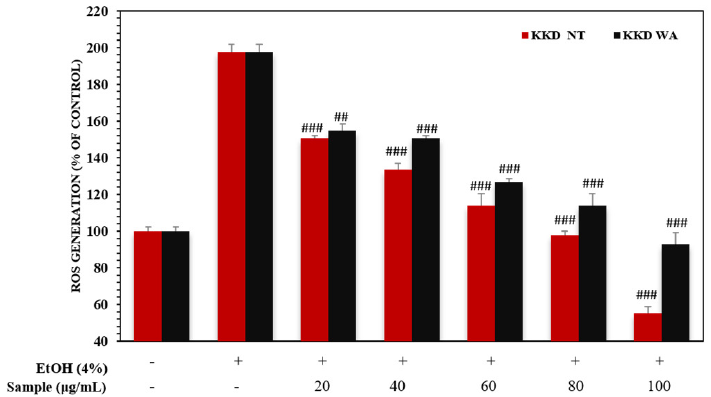
Figure 5. Effect of KKD-NT and KKD-WA on intracellular ROS levels in EtOH-induced HepG2 cells. Cells were treated with different concentrations of KKD-NT and KKD-WA in medium containing 4% EtOH. Values are expressed as mean ± SE ( n = 3). ## p < 0.01, ### p < 0.001, compared with the EtOH control group.